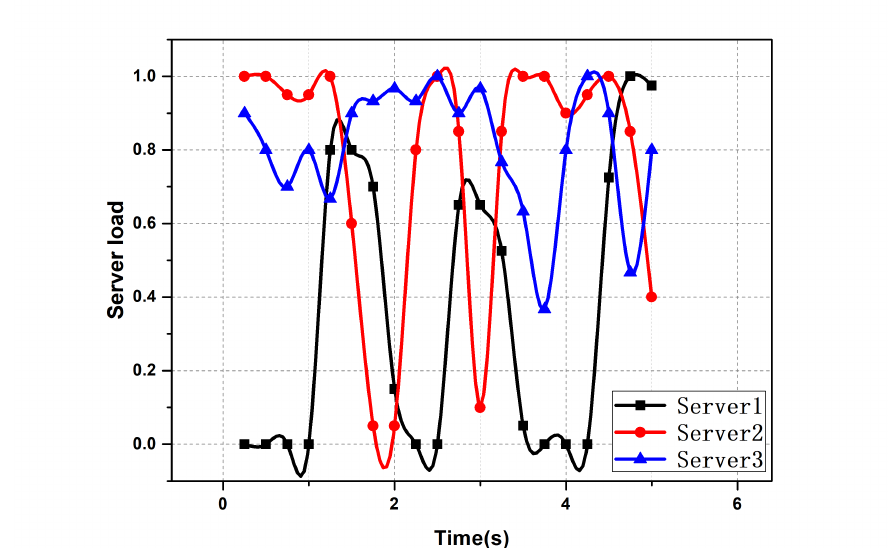
Figure 6. The fluctuation of the server load in the case of server selection based on a random